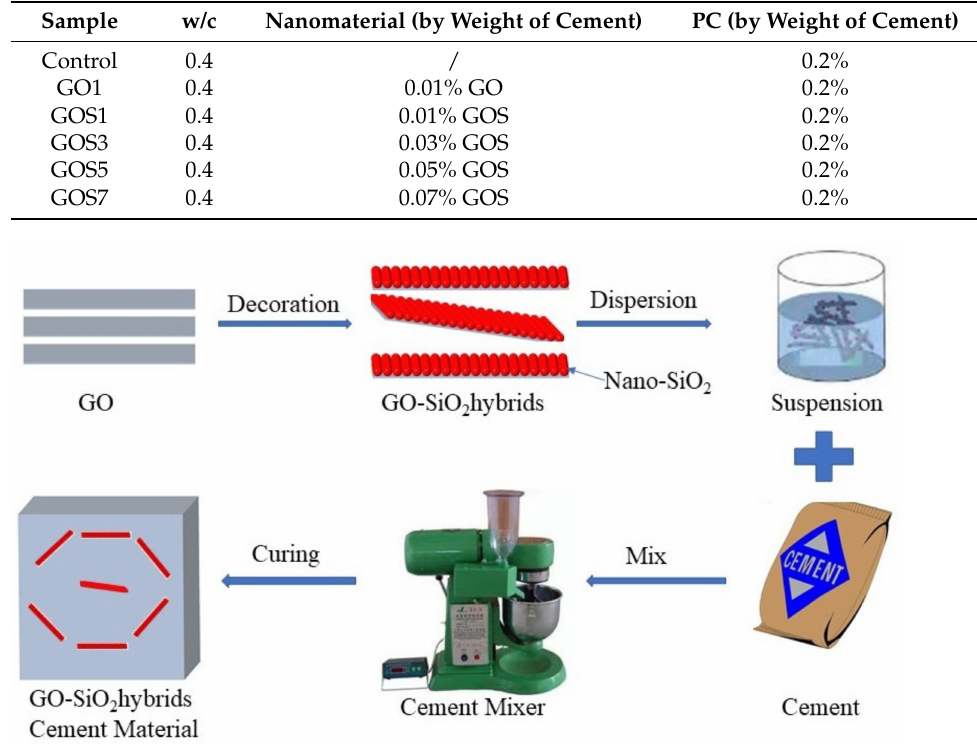
Figure 1. GOS cement-based material preparation process.